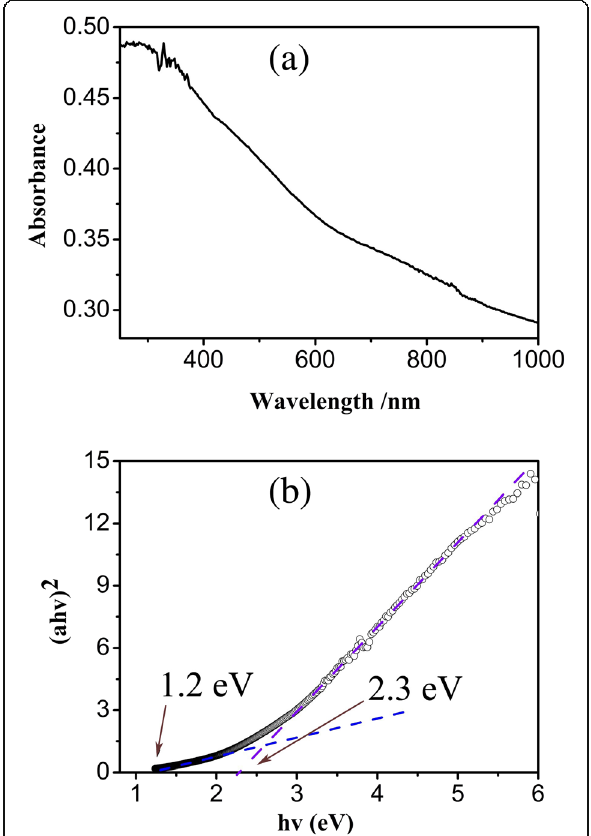
Fig. 2 a UV-Vis absorption spectrum of the NiCo 2 O 4 nanowires. b Optical band gap energy of NiCo 2 O 4 nanowires obtained by extrapolation to ( α hv) 2 = 0